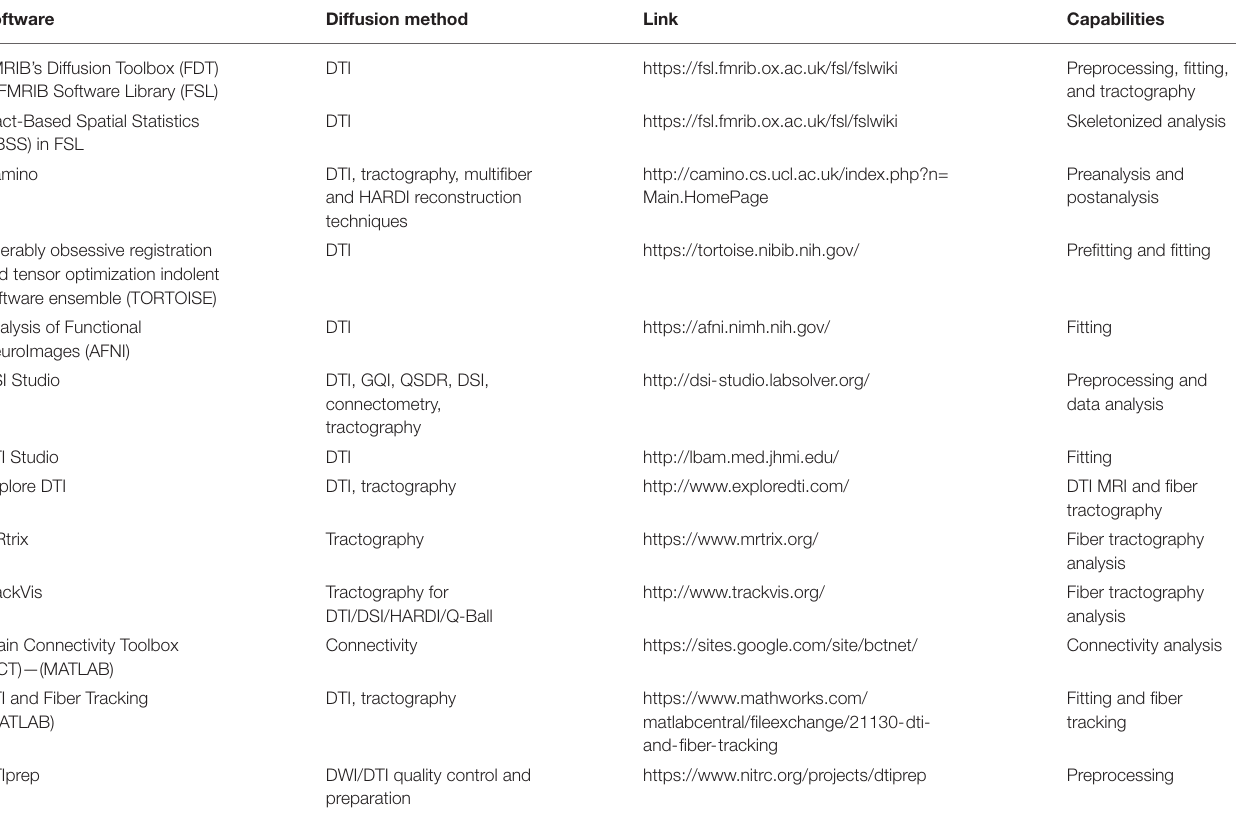
TABLE 2 | List of the main software for dMRI data processing and analysis available. Software Diffusion method